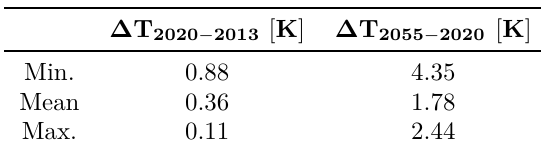
Table 1. Summary of the LST differences between 2020 and 2013 as well as 2055 and 2020